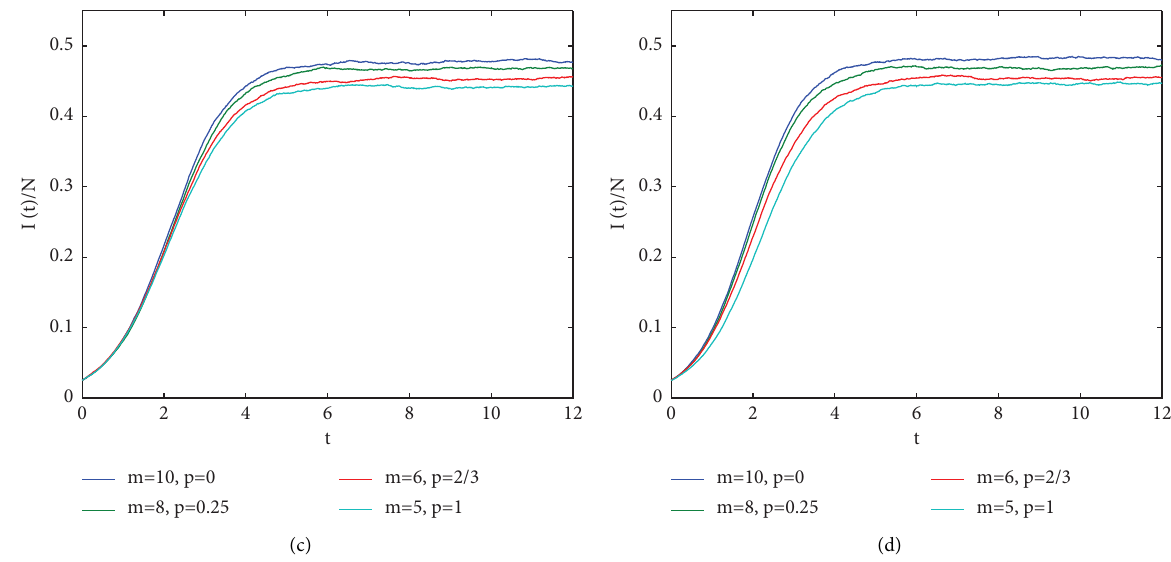
Figure 6: Time dependence of the densities of infectious nodes based on the average of 200 stochastic simulations for diferent values of m and p . Te lines are averaged over 200 stochastic simulations according to the algorithm of epidemic spreading on evolving networks in Section 3.2, and the parameter values are λ � 0 . 3, μ � 0 . 5, c � 1, N � 2000, (a) M � m , (b) M � 20, (c) M � 40, and (d) M � N